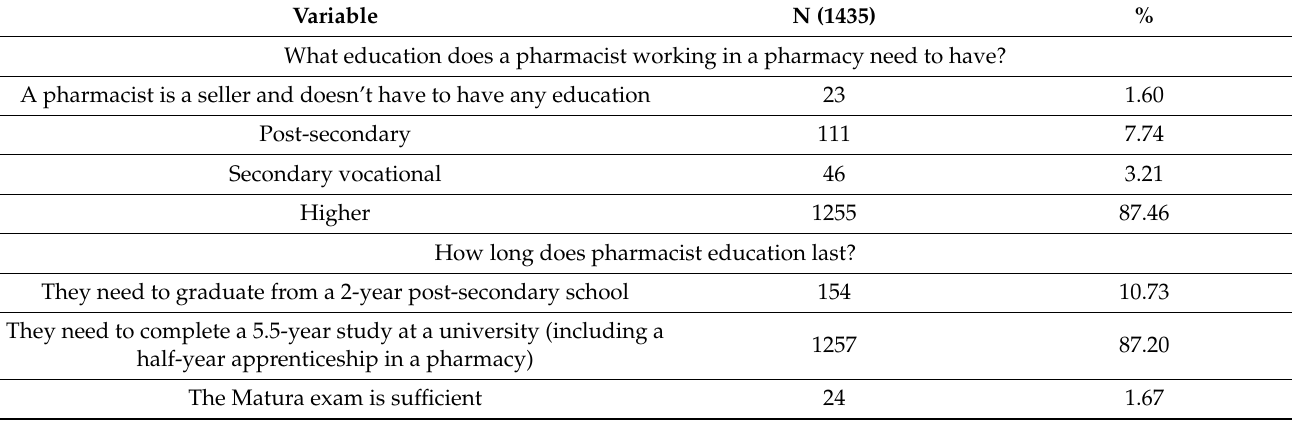
Table 2. Evaluation of